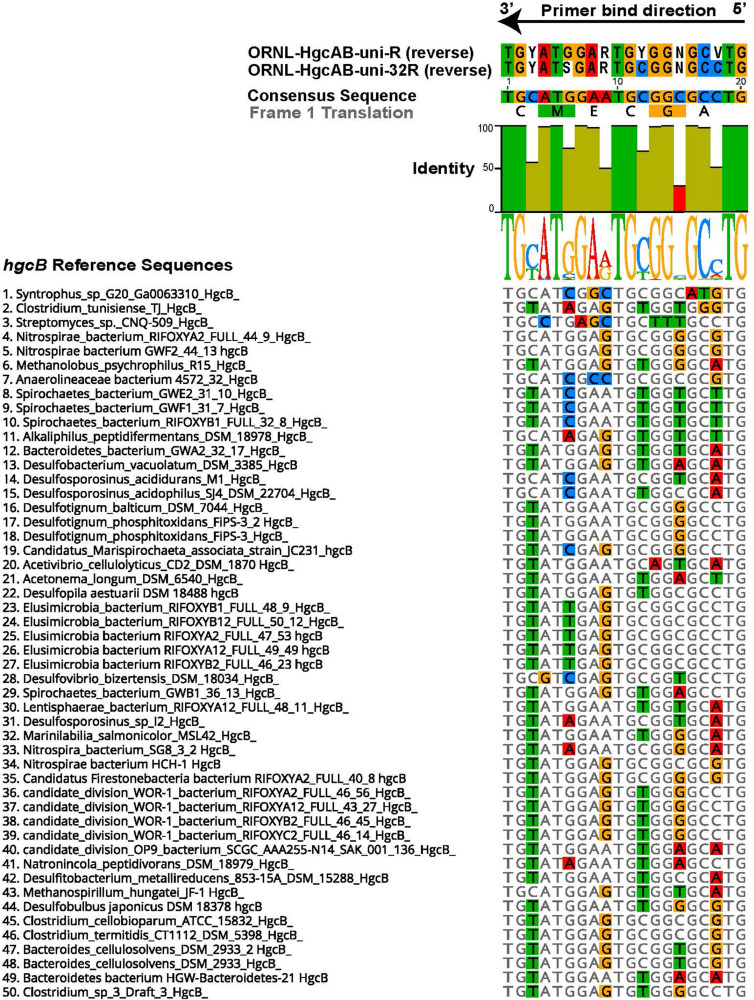
Alignment showing the highly conserved 20 nt bp region of hgcB where the reverse primer binds. Alignment is based on 239 reference hgcB sequences, however only the top 50 sequences most divergent from the consensus sequence are shown. Bases that disagree with consensus sequence are highlighted. Reverse complements of each primer (ORNL-HgcAB-uni-R, ORNL-HgcAB-uni-32R) are included for reference. The bar graph at the top of the image shows mean pairwise identity for each base across all sequences – green is 100%, green-brown is between 30 and 100%, and red is < 30% conserved in 239 sequences. Y = C/T, R = G/A, V = C/G/A, S = C/G, N = A/T/C/G.